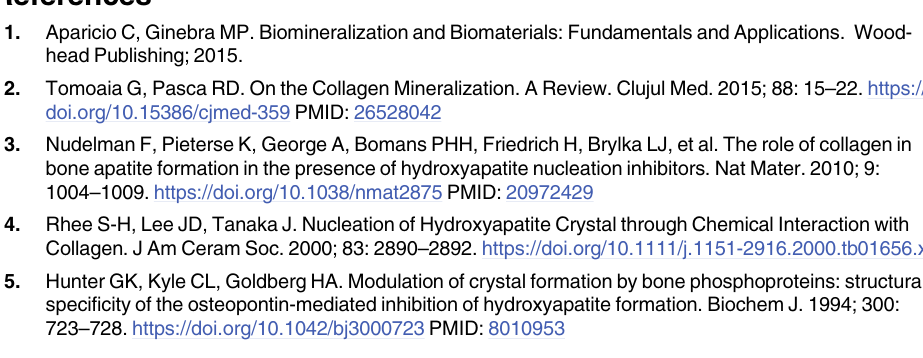
S4 Fig. Analysis of Kokubo’s SBF via IC compared to theoretical values for Kokubo’s SBF and HBSS, as well ECF (plasma). Ion Chromatography of Kokubo’s SBF shows that the com- position is nearly identical to the calculated theoretical values, as well as the composition of commercial SBF (Hank’s Balance Salt Solution, HBSS) [67]. In addition, it is also similar to the composition of ECF [42], with the exception of the amount carbonate, which is taken to be much lower than that of ECF given the theoretical